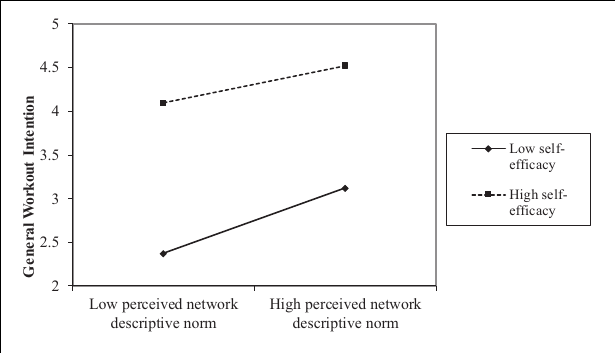
FIGURE 2 | Self-efficacy moderated the relationship between perceived descriptive norm of workout and workout intention next